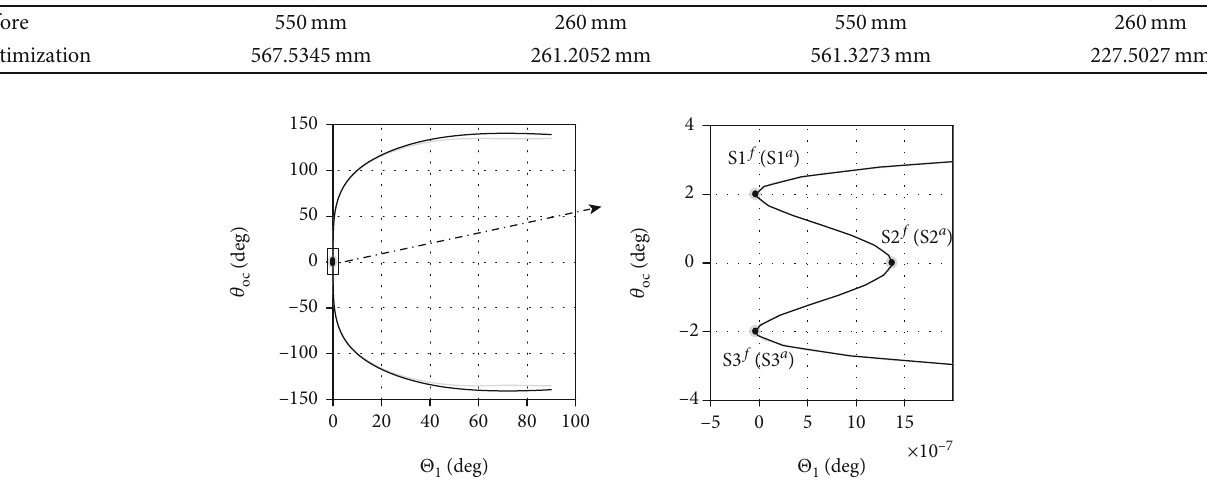
Figure 18: Singular points of dual-sidestay links after optimization. Table 3: Parameters of the SS landing